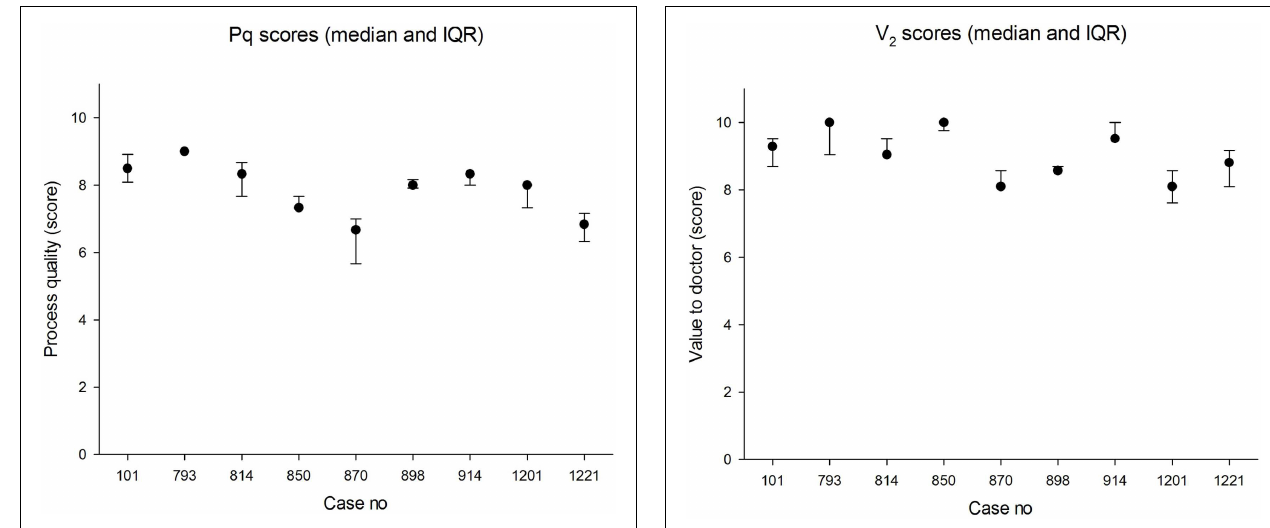
FIGURE 1 | Median scores for process quality (0 = worst; 10 = best) .The error bars indicate the 25th and 75th percentiles.